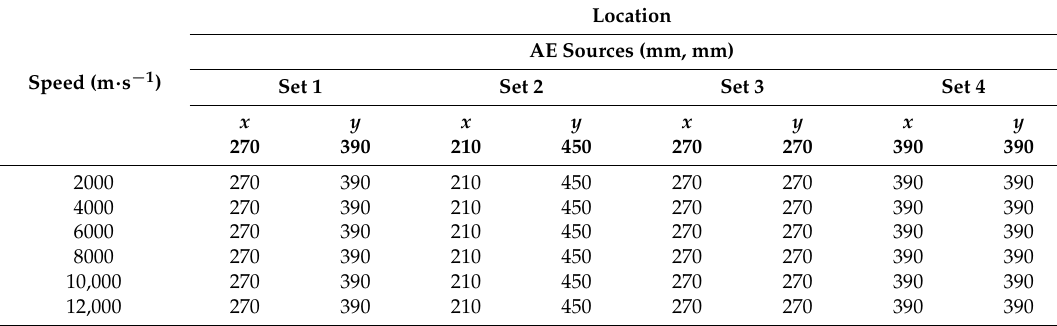
Table 3. Localization results of fast Bartlett beamforming under inaccurate wave